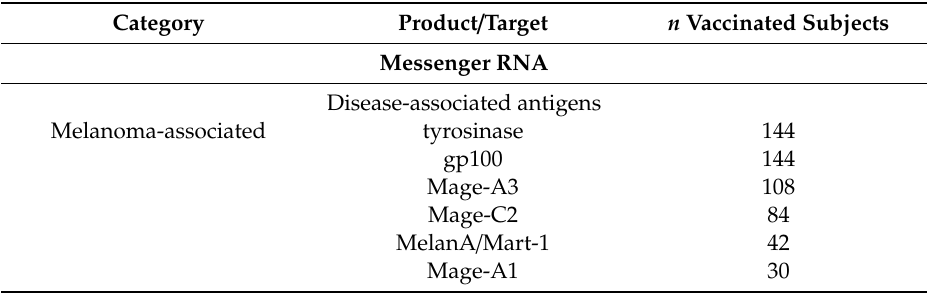
Table 1. In vitro transcribed (IVT) RNA products investigated in RNA-modified dendritic cell vaccination clinical